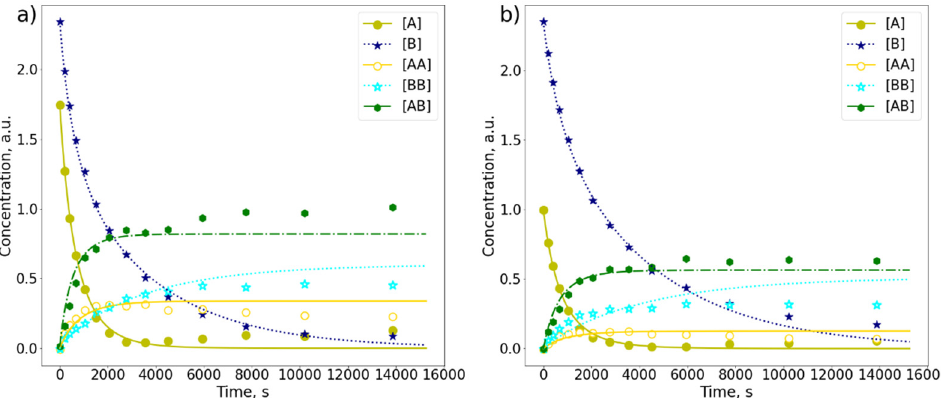
Figure 8. The comparison of photodimerization curves ( λ = 365 nm) derived from 400 MHz 1 H-NMR spectra of anthracene ( A ) and 9-bromoanthracene ( B ) in the mixture with molar mixing ratios ( a ) 1:1.3 and ( b ) 1:2.3. Three dimmers are observed: AA , BB and AB .